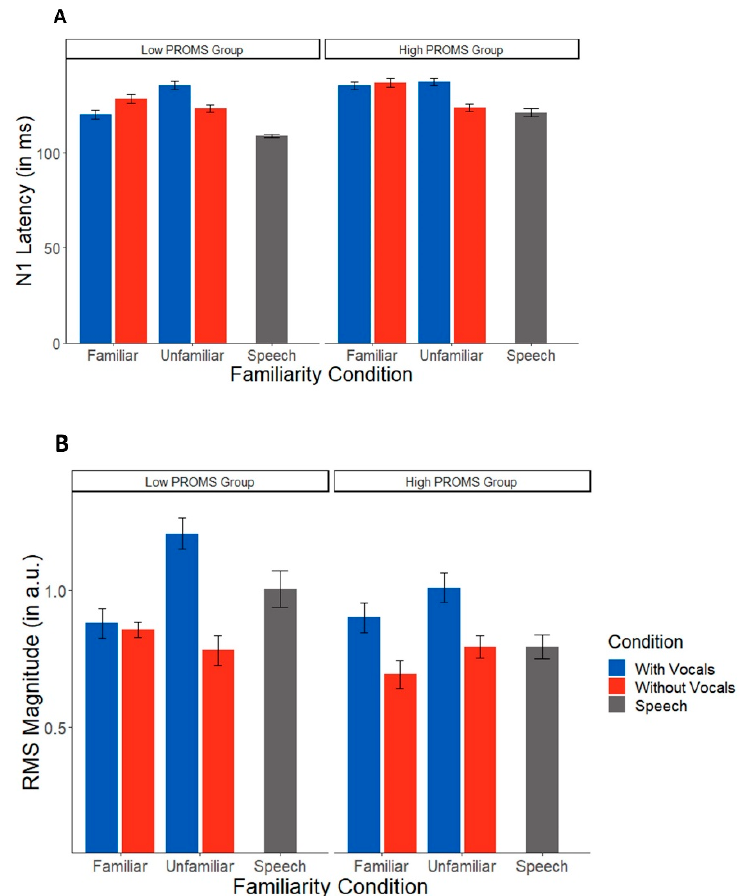
Figure 5. Speech TRFs vary as a function of musical aptitude (controlling for musical training). ( A ) Latencies were shorter for instrumental music than vocals only in the unfamiliar condition. ( B ) In- strumental music produced smaller speech responses than songs with vocals in both groups. PROMS = Profile of Music Perception Skills test. Error bars represent ± 1 standard error of the mean.